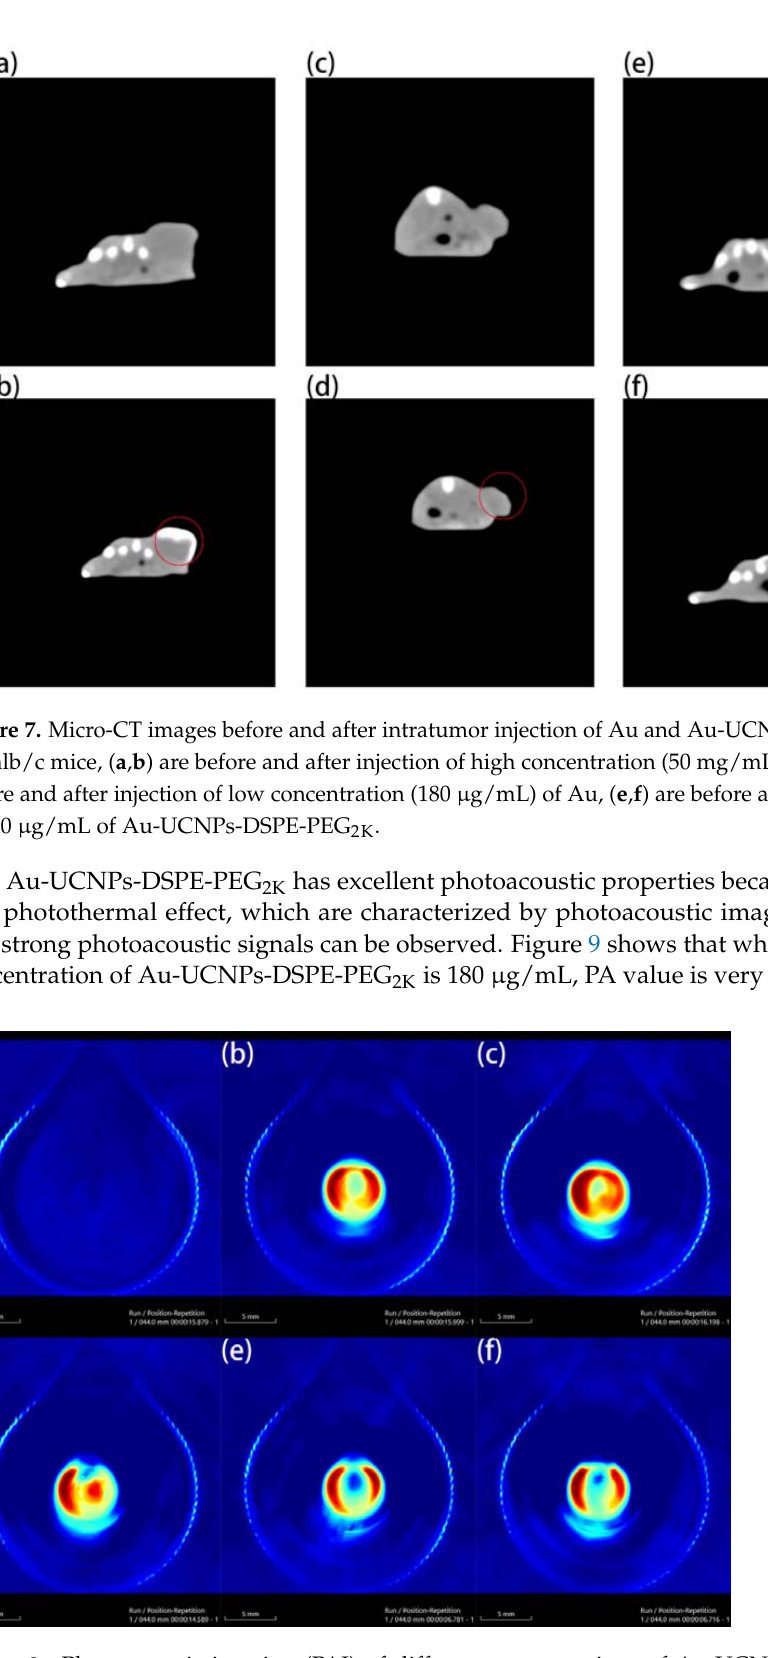
Figure 8. Photoacoustic imaging (PAI) of different concentrations of Au ‐ UCNPs ‐ DSPE ‐ PEG 2K , ( a ) 0 μ g/mL, ( b ) 60 μ g/mL, ( c ) 120 μ g/mL, ( d ) 180 μ g/mL, ( e ) 240 μ g/mL, ( f ) 300 μ g/mL.